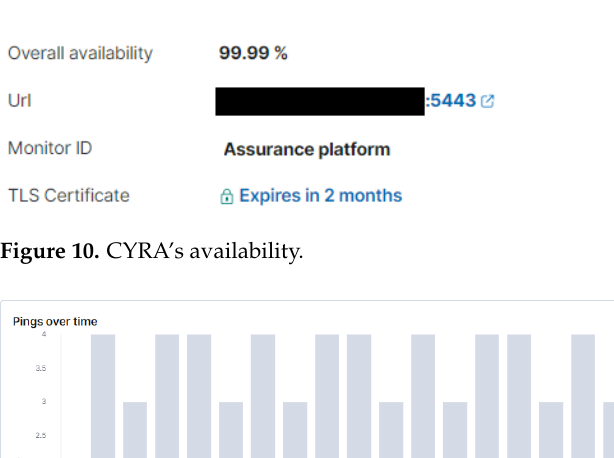
Figure 9. Mean CPU and memory usage (heavy platform usage).